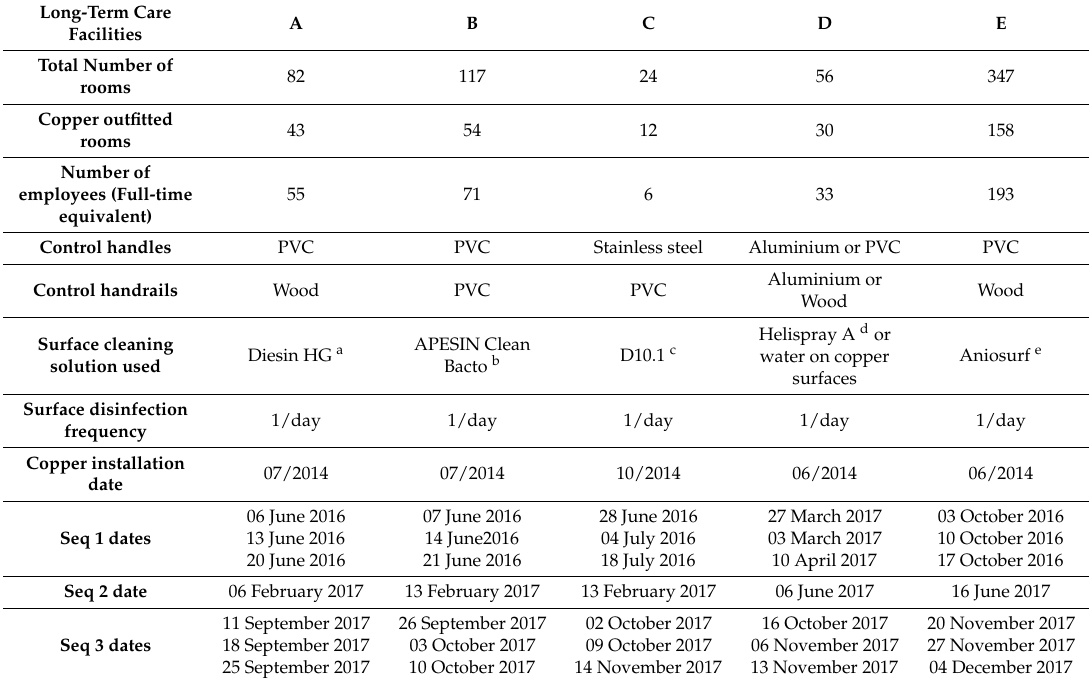
Table 1. Long-term care facilities: Key parameters for the setting of the